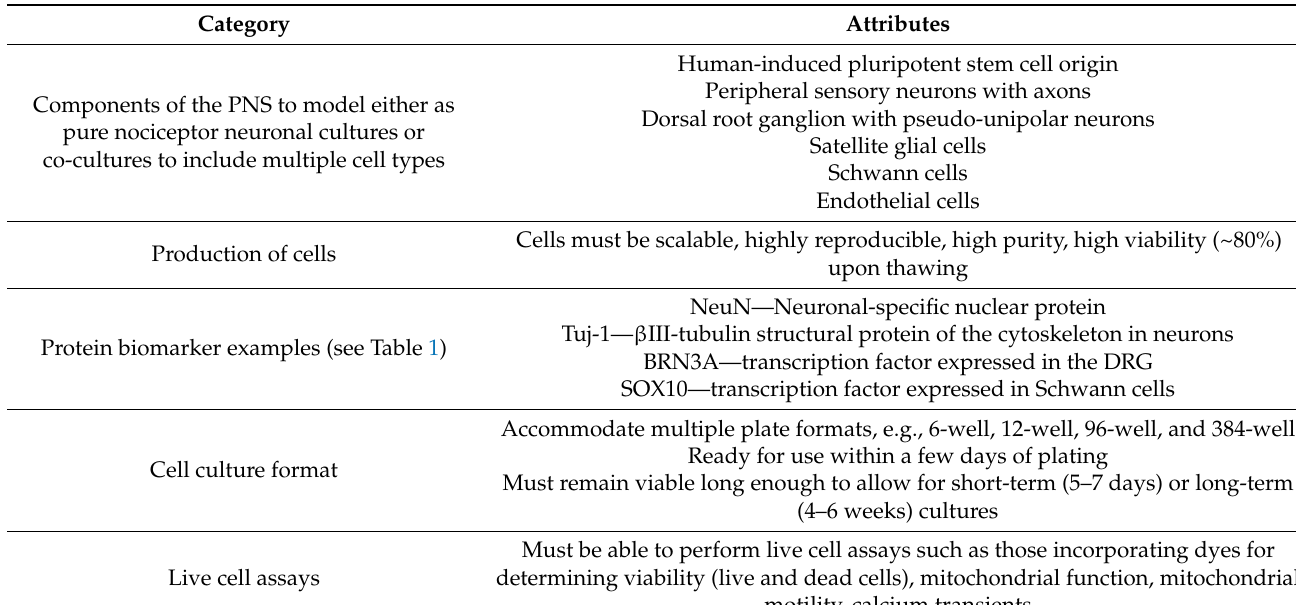
Table 4. Attributes of an “ideal” cell-based system to model